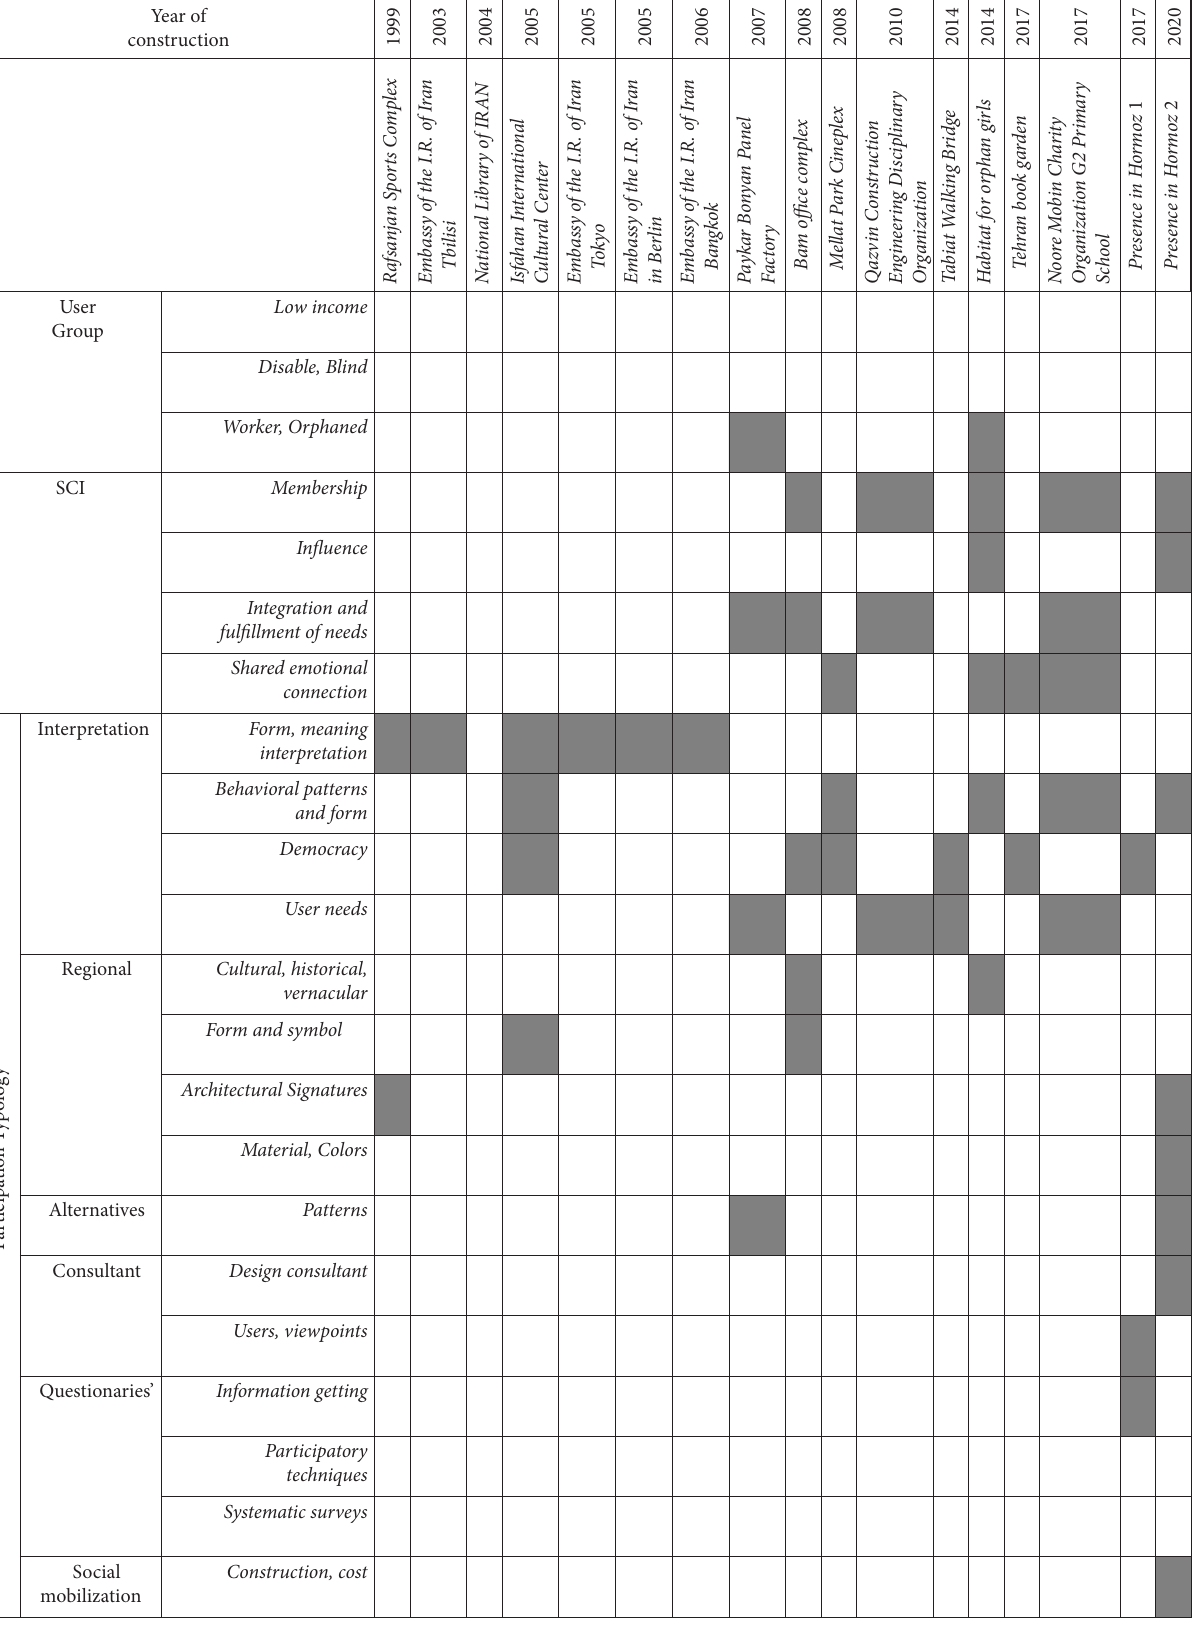
Table 8. Analyze community design factors in selected cases of contemporary Iranian architecture (1978–2020) Year of